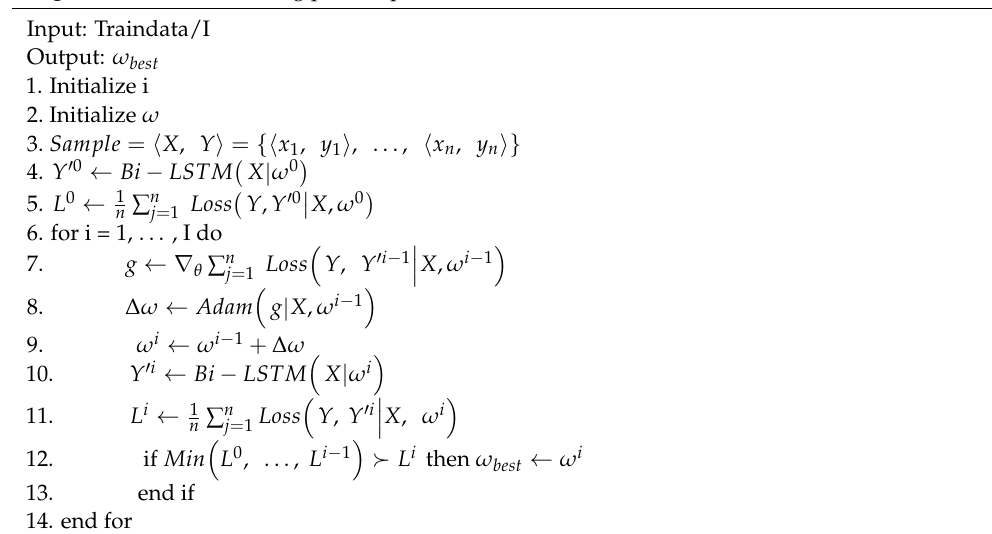
Algorithm 1 Model training process